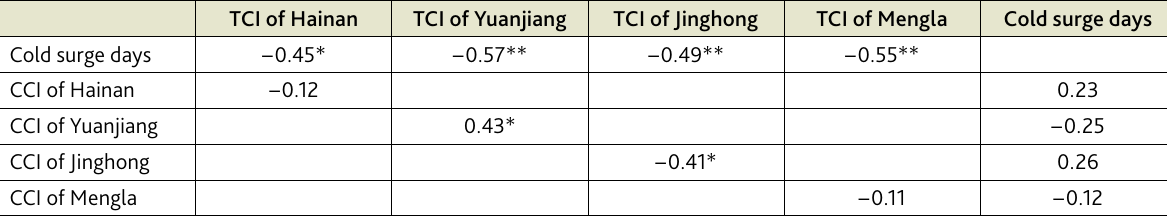
Table 7. Correlation coefficients between the TCI and CCI, the TCI and cold surge days, and the CCI and cold surge days in Hainan and Yunnan (Yuanjiang, Jinghong, and Mengla) from 1981 to 2010 (* and ** denote significance levels of 95% and 99%,